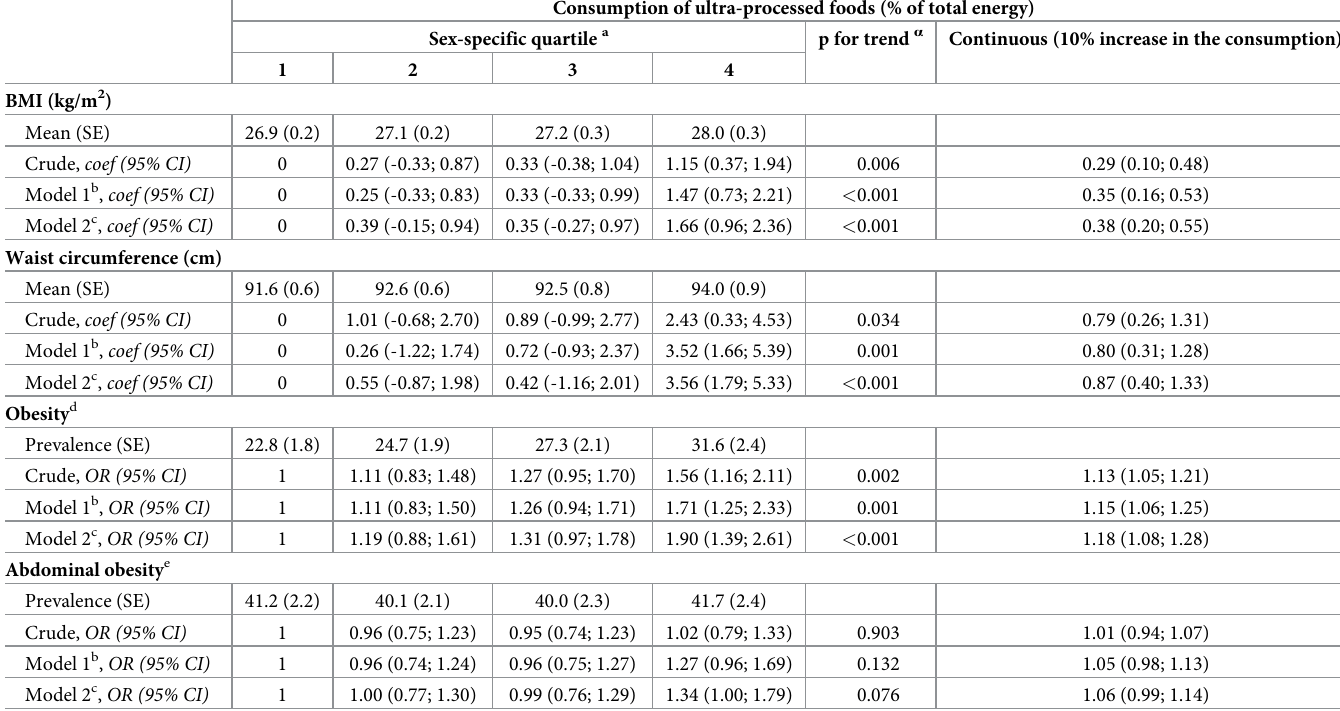
Table 3. Crude and adjusted analyses of the association between the dietary contribution of ultra-processed food and indicators of obesity among the UK popula- tion aged 19 years or over (NDNS, 2008 ─ 16). Consumption of ultra-processed foods (% of total energy)